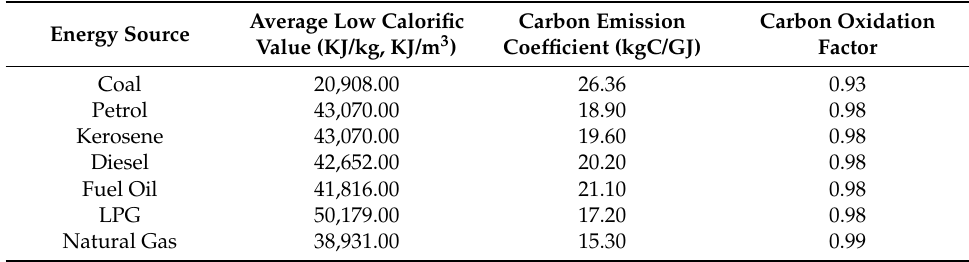
Table 3. Energy-related parameters. LPG: Liquefied Petroleum